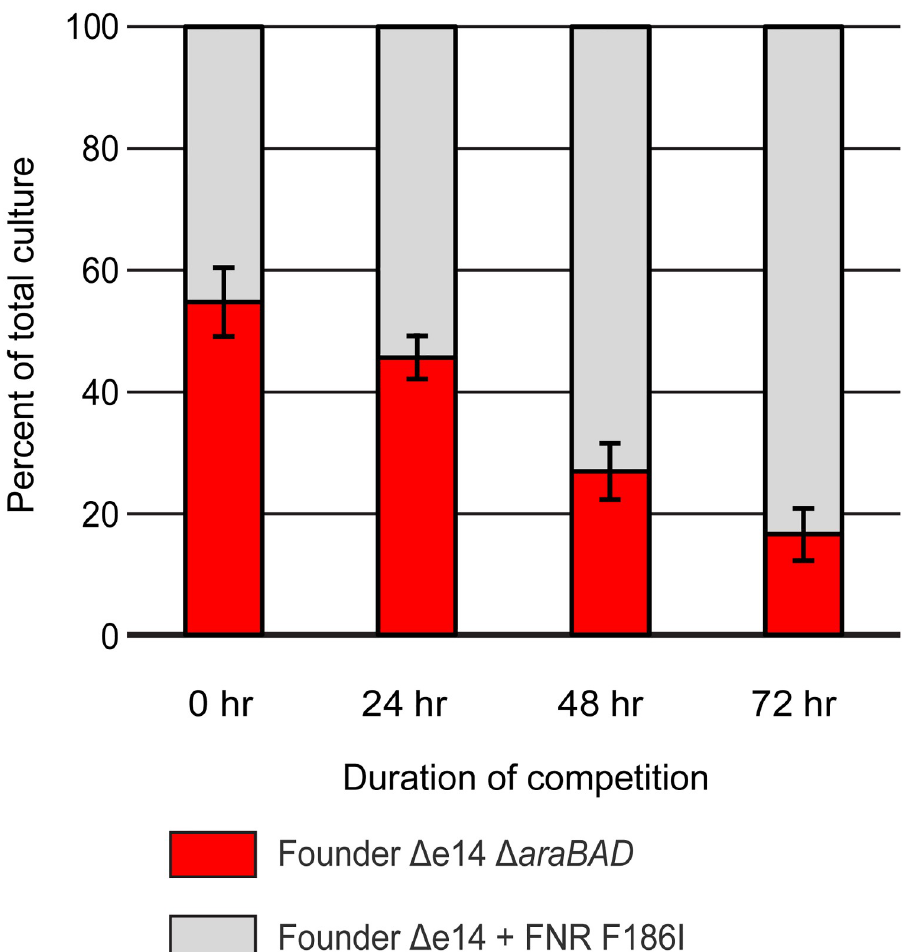
Fig 5. FNR F186I enhances growth competition of Founder Δ e14 in mixed culture without selection. Founder Δ e14 + FNR F186I outcompetes Founder Δ e14. These data represent a single, representative competition against Founder Δ e14 without the araBAD operon (a neutral mutation used to differentiate strains in the competition; loss of the araBAD operon results in red colonies on TA medium). Growth competitions were carried out as described in the Materials and Methods. Data for these experiments are contained in the Supporting Information (S5 File. Growth competition raw data).